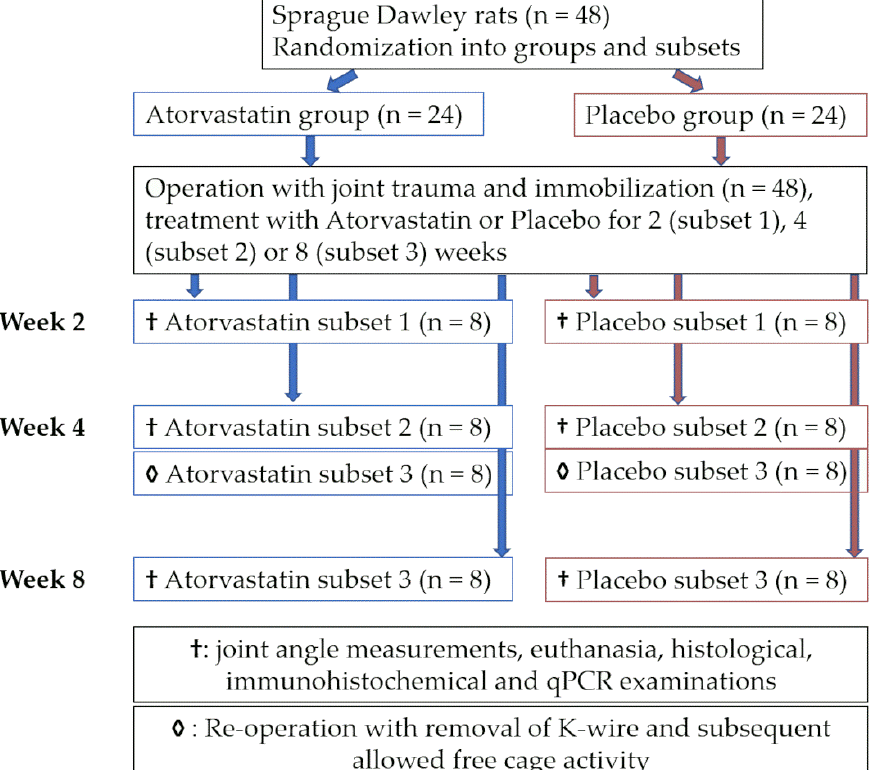
Figure 1. Animal allocation to atorvastatin and placebo groups and subsets.